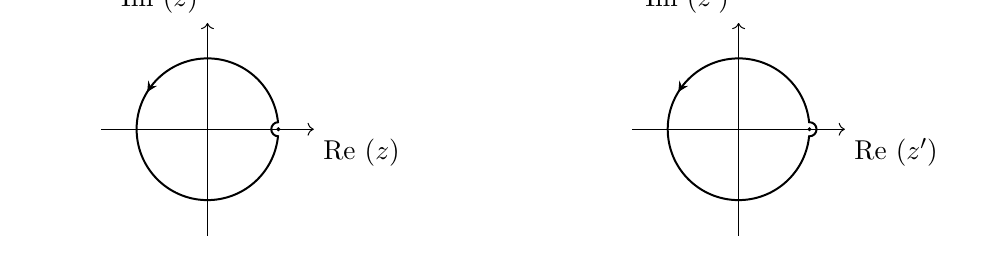
Figure 3 . Integration contour γ + in z 0 -plane. Pole at z 0 = 1 is